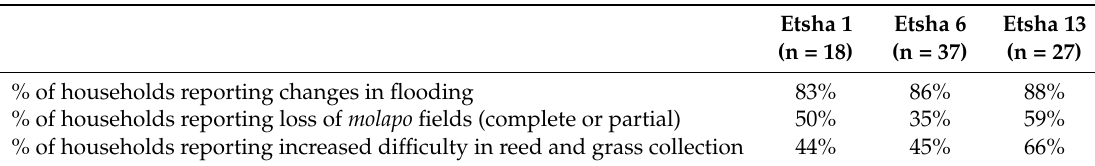
Table 2. Perceptions of changes in flooding and related livelihood